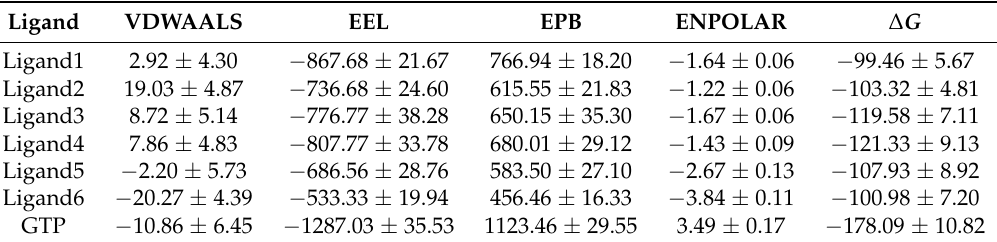
Table 2. Contribution of energies (kcal/mol) in MM/PBSA